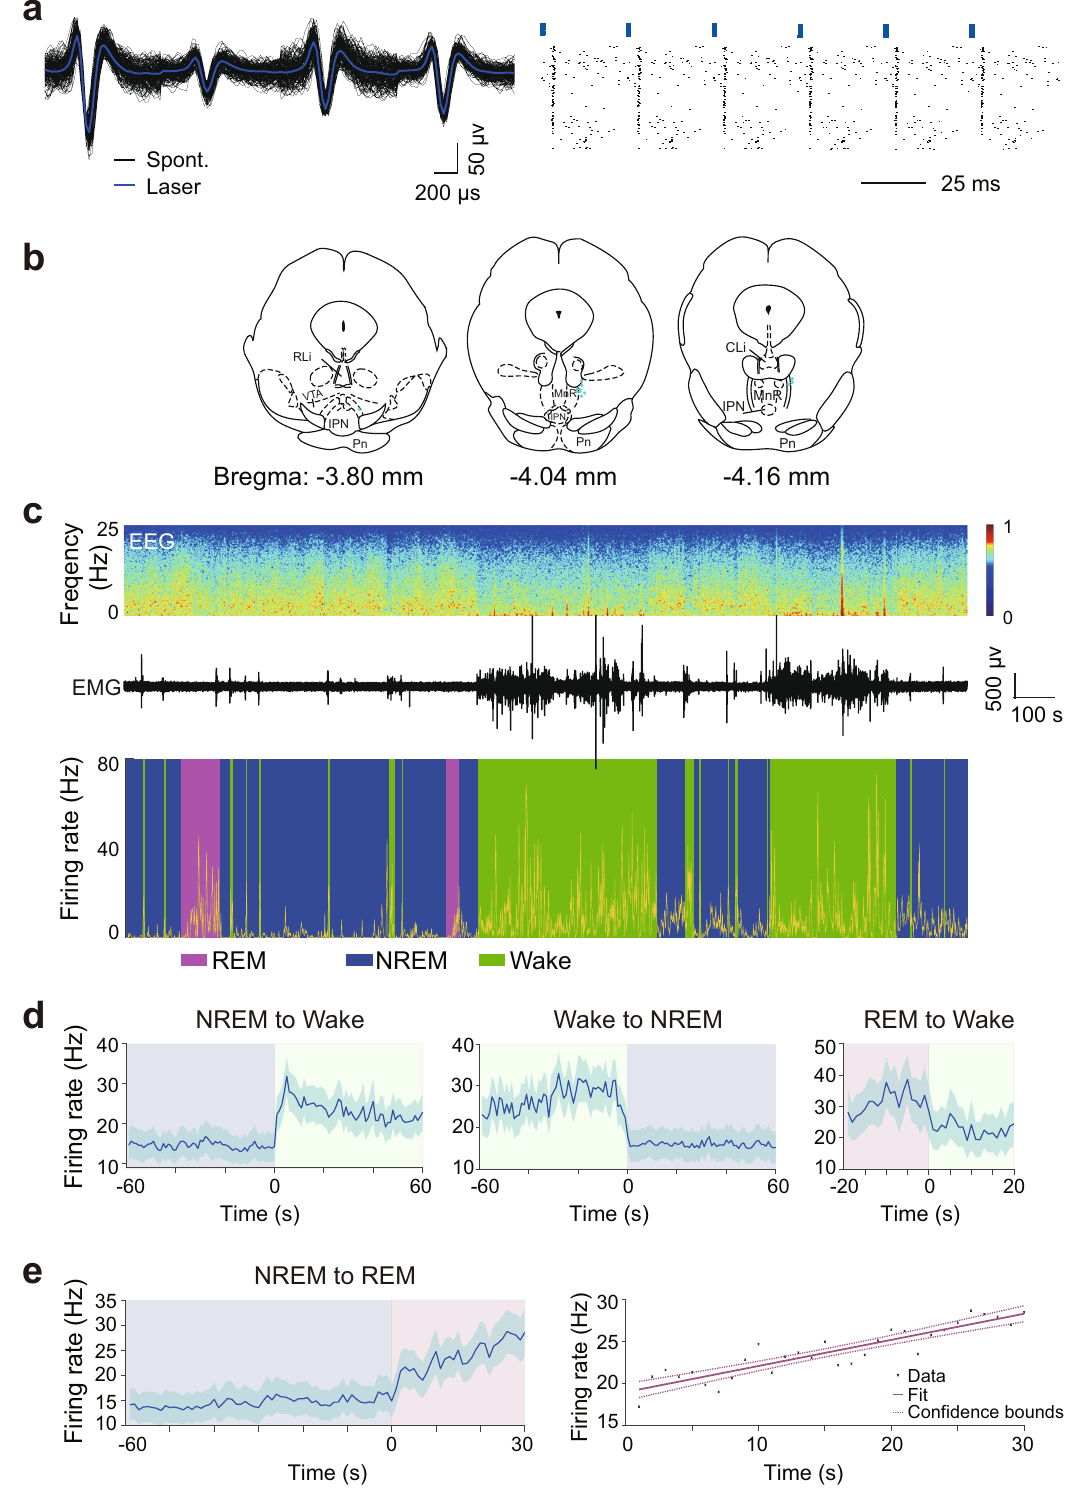
Fig. 4 | Firing rates of identi fi ed RMTg GABAergic neurons across brain states. a An example unit. Comparison between laser-evoked (blue) and spontaneous (black)spikewaveformsfromthisunit(left).Spikerastershowingmultipletrialsof laser stimulation at 30Hz. Blue ticks, laser pulses (right). b Recording sites of 12 identi fi edunitsacrosstherostrocaudalextentoftheRMTginVGAT-Cremice.Each indigodotindicatesoneunit. c FiringratesofanexampleRMTgGABAergicneuron (yellow) together with the EEG spectrogram, EMG amplitude, and color-marked